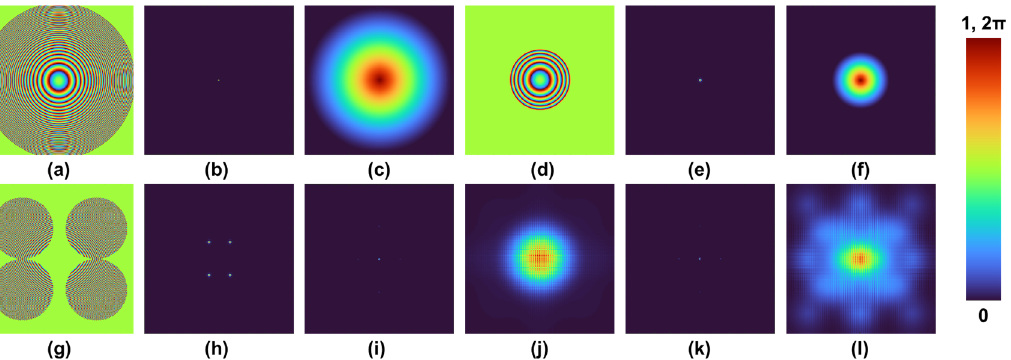
Figure 4. ( a ) Phase image of ideal diffractive lens and its ( b ) PSF and ( c ) MTF. ( d ) Phase image of a sub-aperture diffractive lens and its ( e ) PSF and ( f ) MTF. ( g ) Phase image of LADISA with four apertures and its ( h ) PSF; ( i ) autocorrelation obtained using NLR and its ( j ) MTF; ( k ) autocorrelation obtained using LRRA and its ( l )